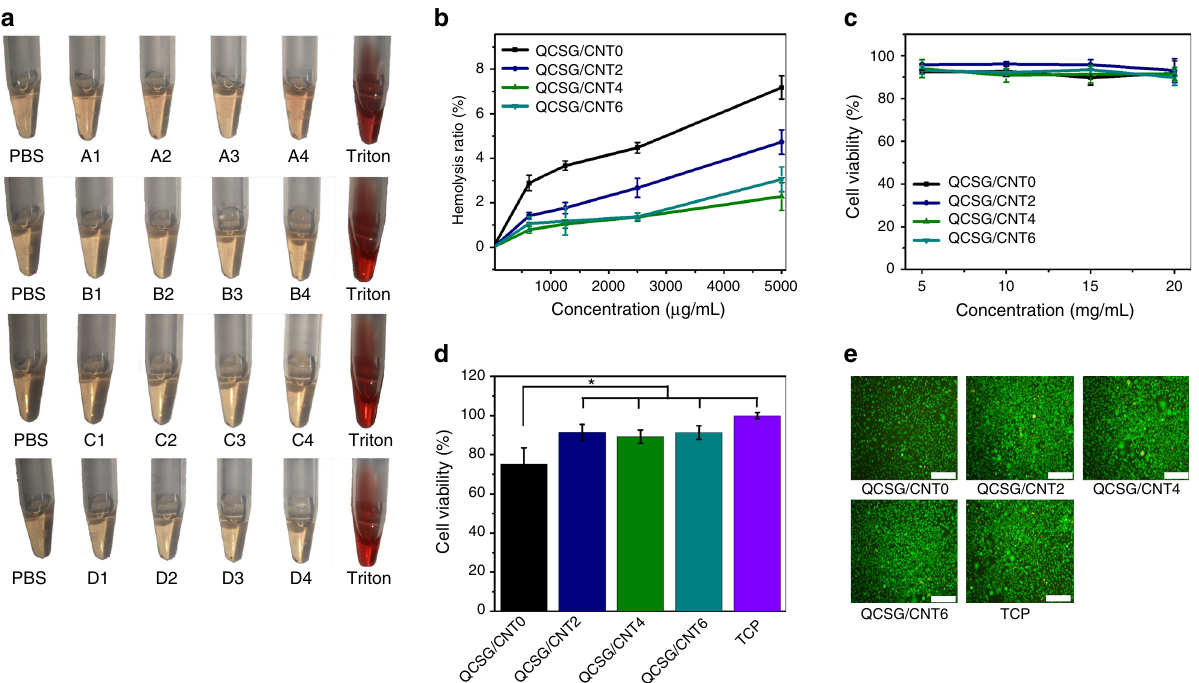
Fig. 5 Biological properties assays for the cryogels. a Photographs from hemolytic activity assay of the cryogels using PBS as negative control and Triton X-100 as positive control. A: QCSG/CNT0, B: QCSG/CNT2, C: QCSG/CNT4, and D: QCSG/CNT6, and the number after the letter stands for the cryogel dispersion liquid concentration that 1 represents 625 µ g/mL, 2 represents 1250 µ g/mL, 3 represents 2500 µ g/mL, and 4 represents 5000 µ g/mL, respectively. b Hemolytic percentage of the cryogels ’ dispersion liquids at different concentrations. When the cryogel dispersion concentrations were equal to or less than 1250 µ g/mL, all the three CNT-contained cryogels just presented less than 1.8% hemolysis, which was lower than that of QCSG/CNT0 (3.6% hemolysis). When increasing the dispersion concentration to as high as 5000 µ g/mL, the three CNT-contained cryogels just presented no more than 4.8% hemolysis. However, the hemolysis ratio of QCSG/CNT0 reached to 7.2%. c Cytocompatibility evaluation of the cryogels ’ extracts for L929 cells. When changing the cryogel extracts ’ concentrations from 5 to 10, 15, and 20 mg/mL, all the four cryogels presented more than 90% L929 cell viability compared with TCP control group ( P > 0.05). d Cytocompatibility evaluation of the cryogels when contacted with the cryogel disks. e LIVE/DEAD staining of L929 cells after contacted with the cryogels for 24 h. Scale bar: 200 µ m. * P < 0.05 using Student's t -test (two-sided). Error bar indicates s.d. ( n =